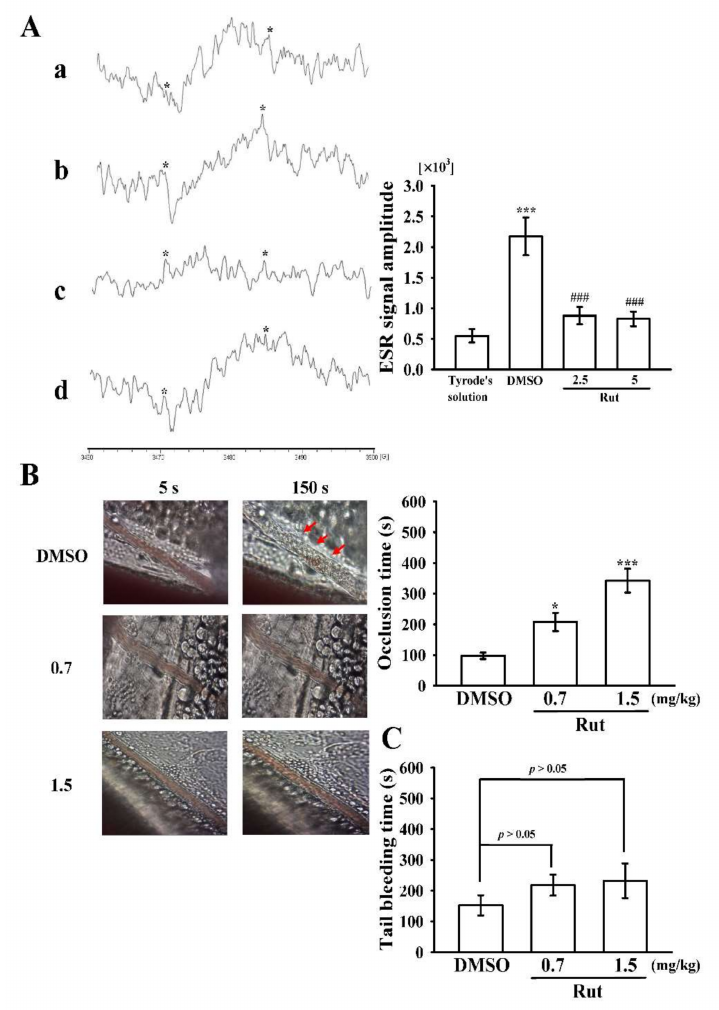
Figure 7. Inhibitory effect of Rut on hydroxyl radical formation in human platelets and microvascular thrombus formation as well as tail bleeding time in mice. ( A ) Washed platelets (3.6 × 10 8 cells/mL) were preincubated with (a) Tyrode’s solution only (resting group) or preincubated with (b) 0.1% DMSO or Rut (c, 2.5; d, 5 µ M); subsequently, collagen (1 µ g/mL) was added to trigger hydroxyl radi- cal (*) formation. Profiles are representative of four similar experiments. ( B ) Mice were administered an intraperitoneal bolus of the solvent control (0.1% DMSO) or Rut (0.7 and 1.5 mg/kg), and the mesenteric venules were irradiated to induce microthrombus formation (occlusion time). Microscopic images (400 × magnification) of the 0.1% DMSO-treated group and Rut (0.7 and 1.5